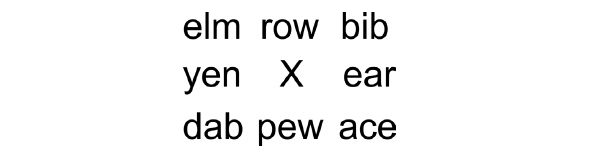
FIguRe 3 | Visual stimuli consisted of eight words surrounding a central fixation point.